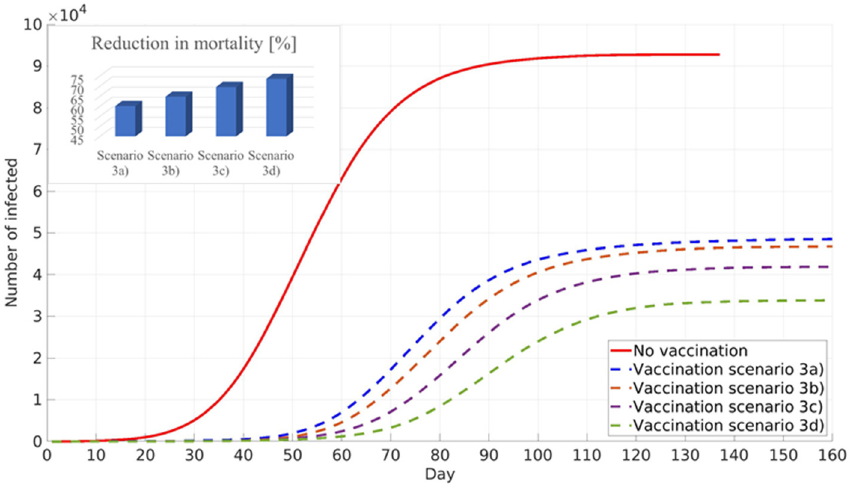
Figure 9. Influence of pre-existing immunity on the cumulative number of infected and reduction in mortality. General population vaccination scenario—minimised number of deceased